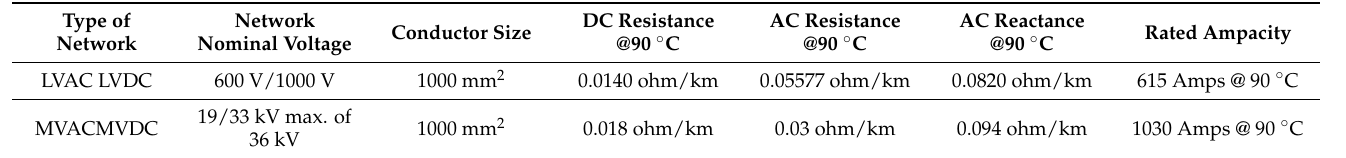
Table A1. Specifications for different cable parameters used in the MV/LV design